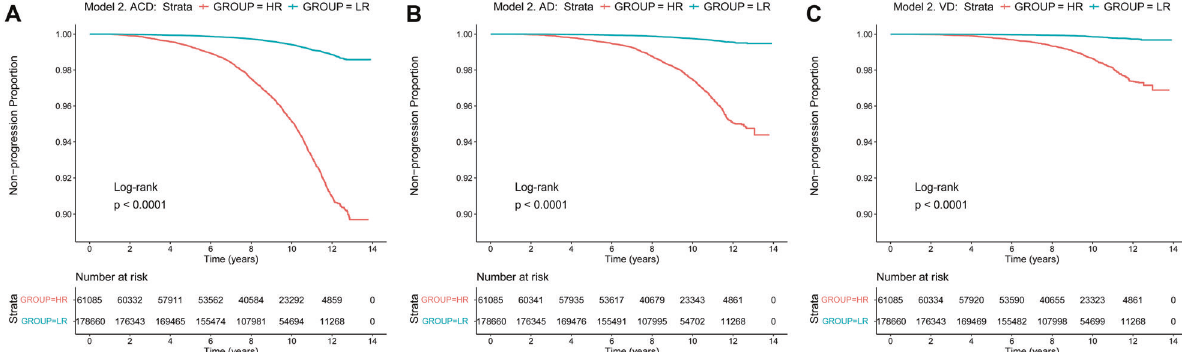
Fig. 4 Kaplan – Meier survival curves predict ACD, AD, and VD risk in the basis of model 2. Patients in the HR group had faster clinical progression ( p logrank < 0.0001) compared with those in the LR group in model 2 for ACD ( A ), AD ( B ), and VD ( C ). ACD all-caused dementia, AD alzheimer ’ s disease, VD vascular dementia, LR low risk, HR high risk.